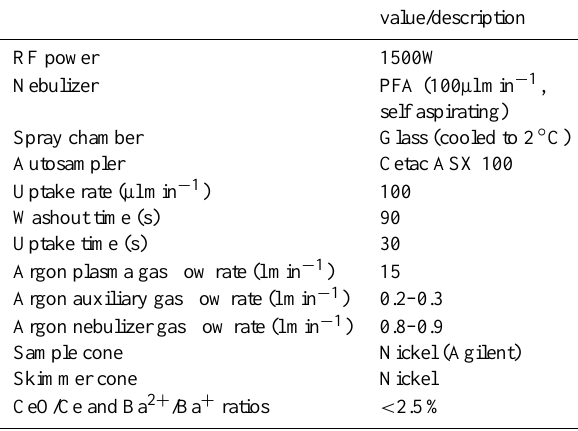
Table A2. Operation conditions for Agilent 7500cx.